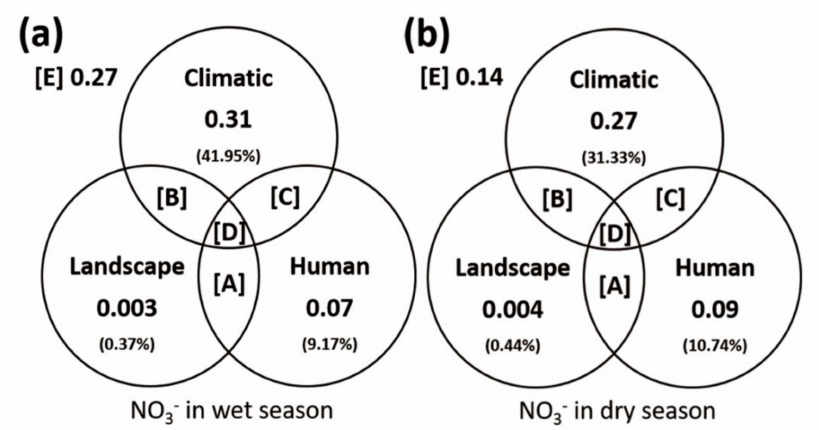
Figure 7. Variance decomposition (conditional e ff ects) of NO 3 − exports in wet ( a ) and dry ( b ) seasons in 43 watersheds. Each circle and the intersections indicate the individual e ff ect of climatic [C], landscape (L) and human disturbance (H) variables and their interactive e ff ects on NO 3 − export from pRDA, including the shared variance of landscape setting and human disturbance (LH) [A], landscape setting and climatic variables (LC) [B], climatic variables and human disturbance (CH) [C], among three variables (CLH) [D], and residual variance [E]. In Panel ( a ): [A] = 0.38 (51.59%); [B] = − 0.002 ( − 0.29%); [C] = 0.04 (5.32%); [D] = − 0.06 ( − 8.09%). In Panel ( b ): [A] = 0.17 (20.00%); [B] = − 0.004 ( − 0.43%); [C] = 0.38 (44.15%); [D] = − 0.05 ( − 6.22%). The percentage of explained variation of variables is equal to the eigenvalue divided by total